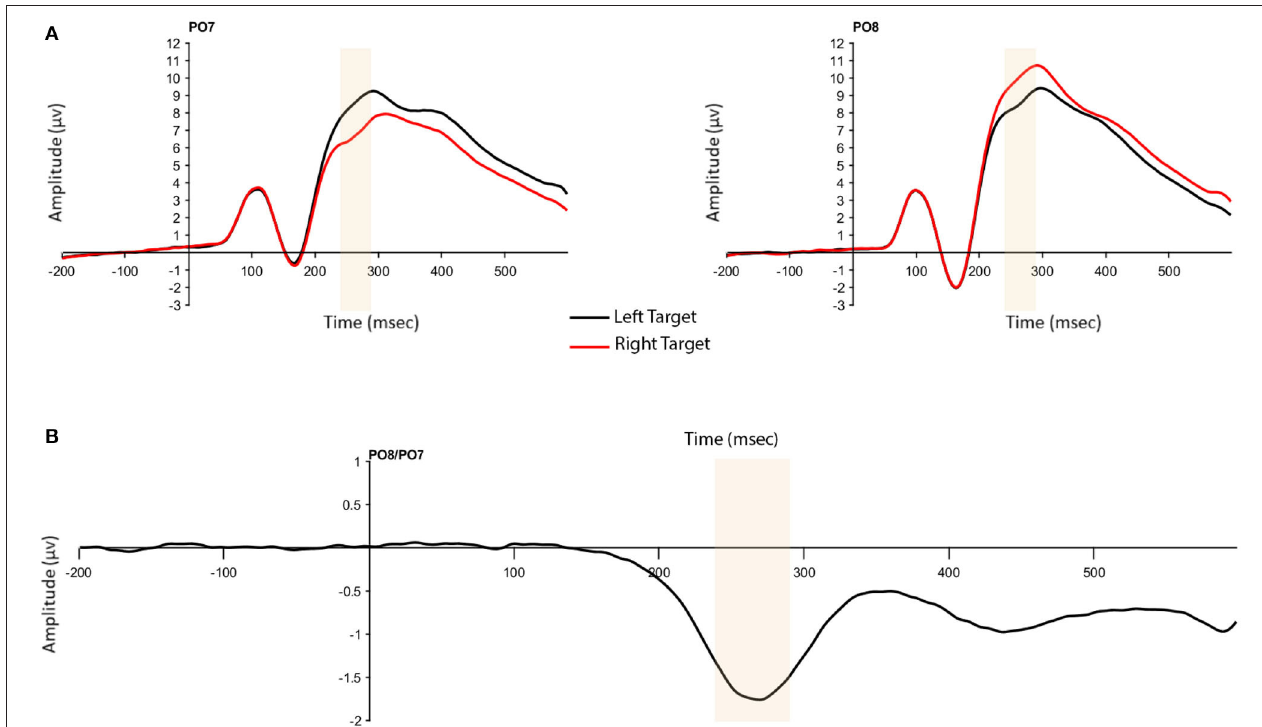
FIGURE 3 | (A) N2pc to targets presented in the left and right hemifield at contralateral and ipsilateral electrodes (P07 and P08). (B) N2pc difference wave. Highlighted window is 240–290ms in both figures.